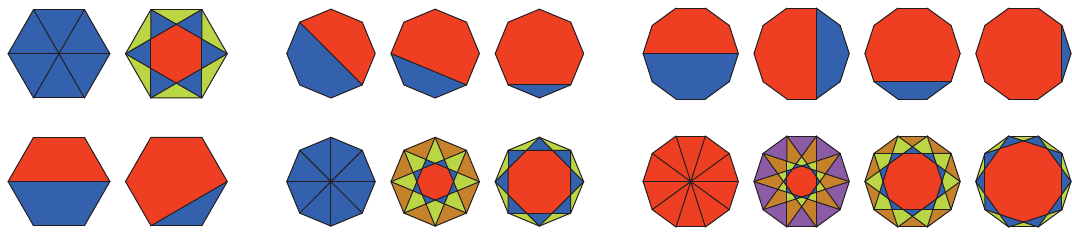
Figure 31. Diagonals through centre for (VV 1; m +2/2 cuts) and central m-polygons created for all other VV cuts. For m = 6, 8,